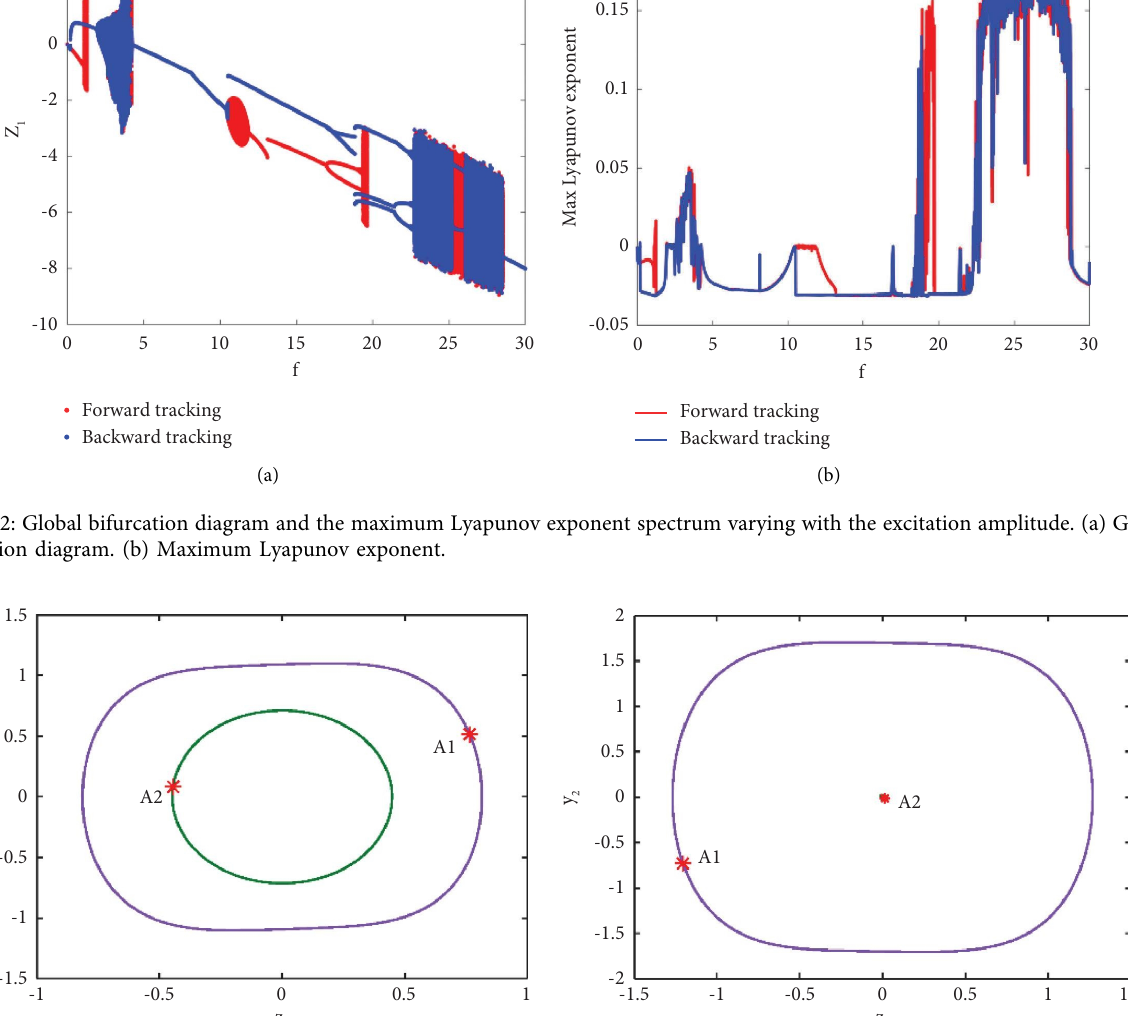
− y analysis plane. (b) Te z 1 1